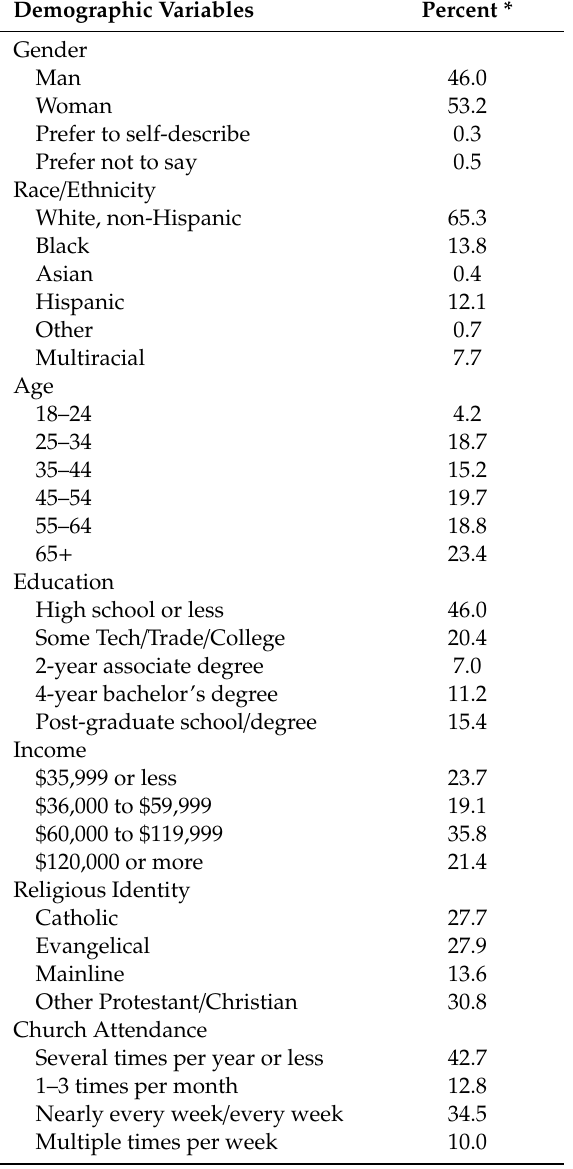
Table 1. Frequency Distribution of Demographic Characteristics Among a Sample of Practicing Christians ( n =